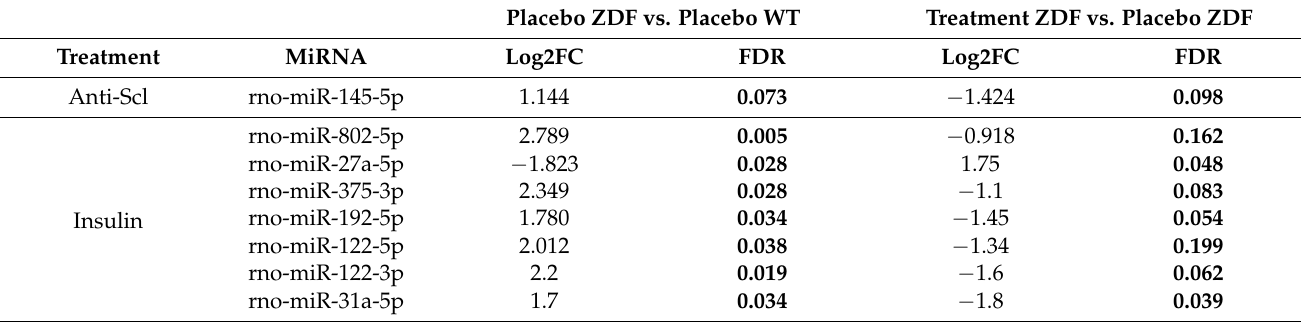
Table 2. Cross-sectional regulation of the rescued circulating miRNAs via anti-sclerostin and insulin treatment. Differential expression of miRNAs in diabetic ZDF rats and after 12 weeks of treatment with anti-sclerostin and with insulin at the study’s end (WT placebo, n = 5; ZDF placebo, n = 5; ZDF anti-Scl, n = 4; ZDF insulin, n = 4). Placebo ZDF vs. Placebo WT Treatment ZDF vs. Placebo ZDF